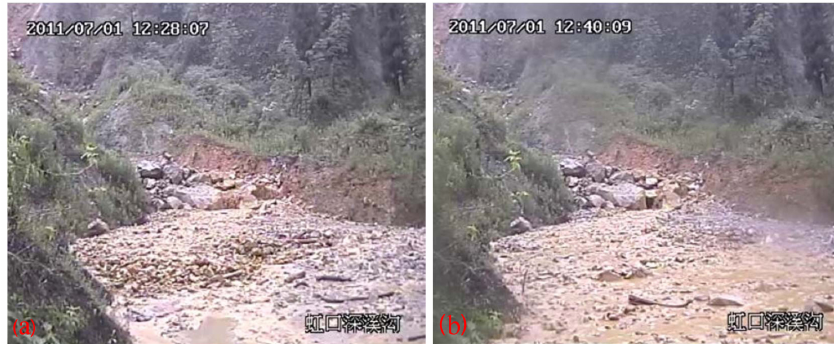
Figure 5. Real-time images from video taken during the debris flow movement.